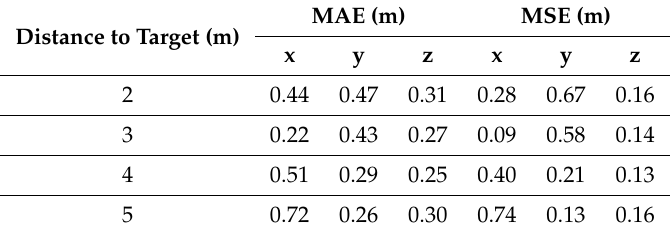
Table 8. Errors of the coordinates estimation module by distance to the target.